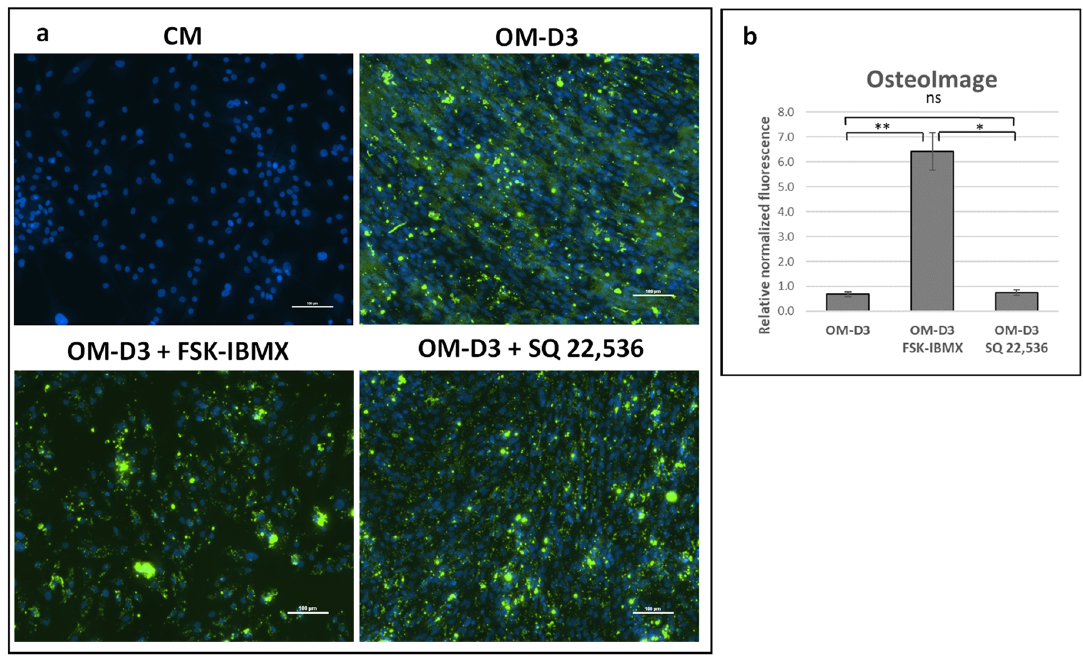
Figure 7. Effect of cAMP on late differentiation events after predifferentiation in spheroids—bone-mineral production. ADSCs predifferentiated in spheroids for 7 days in OM and differentiated for another 14 days on 2D TCPS (total differentiation time was 21 days) in osteogenic-maturation medium (OM-D3) with FSK–IBMX (FSK, 10 nM; IBMX, 500 nM) or SQ 22,536 (100 nM). ( a ) Bone mineral stained with OsteoImage kit (Lonza) and observed under fluorescence microscope (green). Nuclei stained with Hoechst 33,342 (blue). ( b ) Green and blue fluorescence intensity measured with plate reader to semiquantify the bone-mineral amount relative to number of cells in culture. Mean from three experiments performed on cells isolated from di ff erent donors is shown, error bars represent standard deviation. *, p < 0.05; **, p < 0.01; ns, not significant.